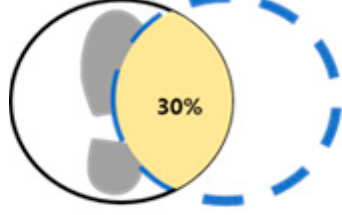
Figure 9. Criteria for foot recognition.